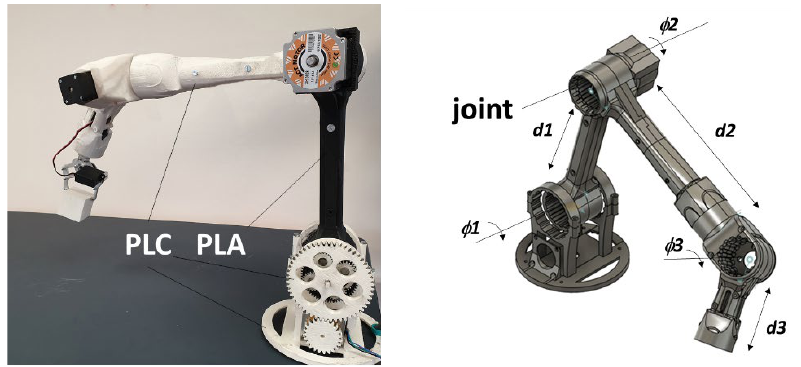
Figure 20. Design of technical parts used to build a robot mechanical arm using PLC with d 1 = 2 9 cm, d 2 = 3 0 cm, and d 3 = 15 cm.